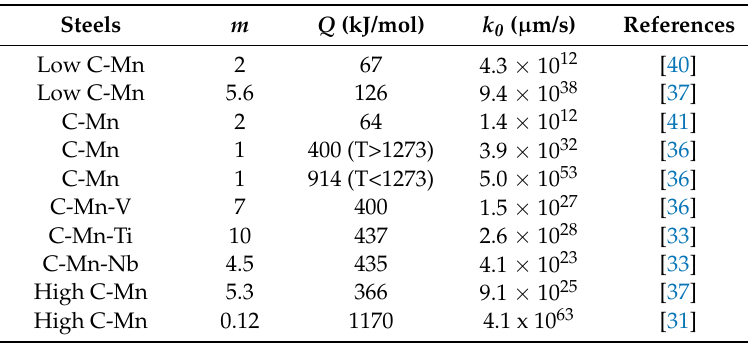
Table 4. Parameters of n , Q , and k 0 for the growth equations.